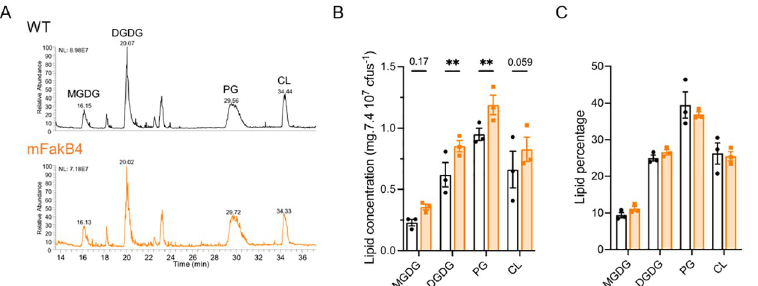
Fig 3. The WT and mFakB4 strains show different lipid quantities, but identical relative lipid composition. Lipid content in the WT and mFakB4 strains grown in THY, by class of lipids: A-B) lipid composition; A) HPLC-MS profile representing the main lipid classes, B) lipid concentration, C) ratio of lipid classes; N = 3 (S2 Table). Bars and symbols, white, WT strain; orange, mFakB4 strain; MGDG, monogalactosyldiacylglycerol; DGDG, digalactosyldiacylglycerol; PG, phosphatidylglycerol; CL, cardiolipin. 2-way ANOVA, Bonferroni post-test, ** p < 0.01; p values are indicated when between 0.05 < p < 0.2.